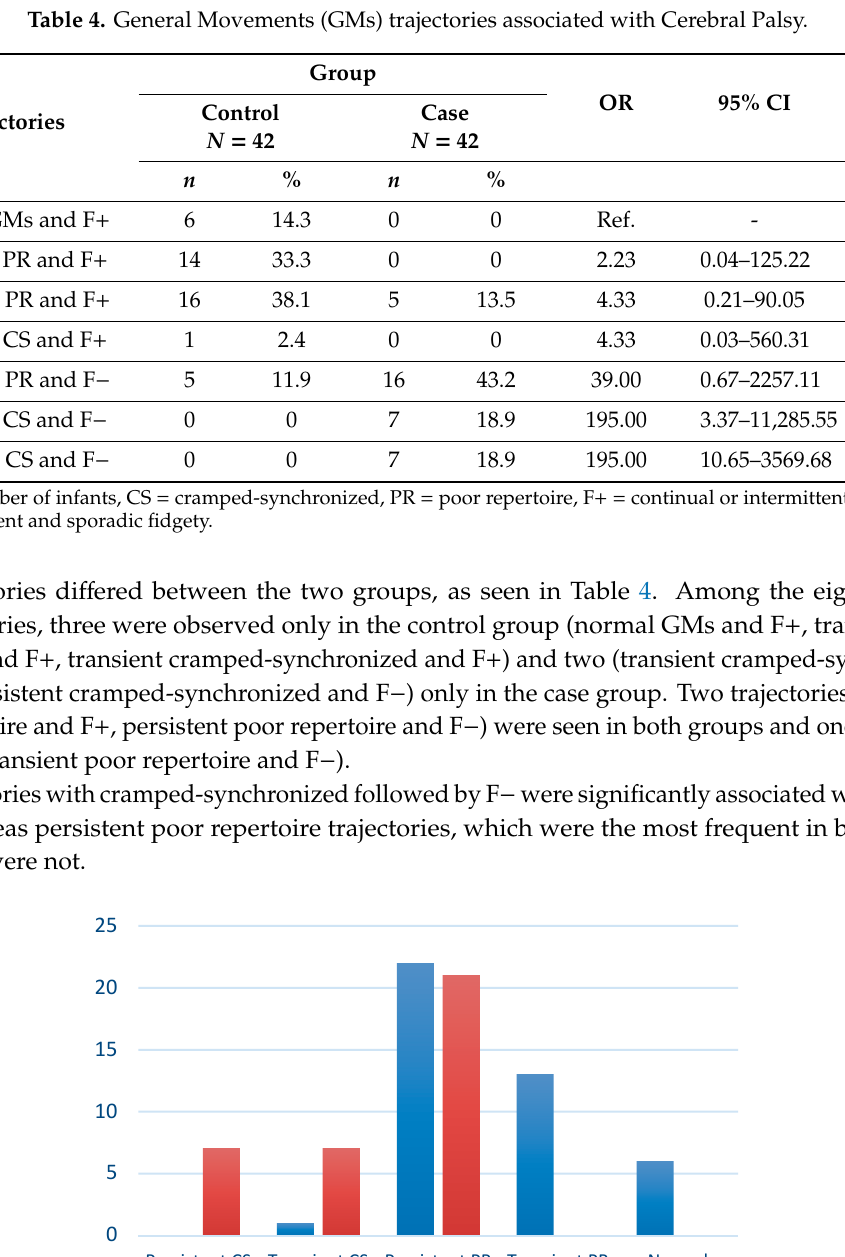
Table 5. Low/high risk GMs trajectories and neurological outcome.